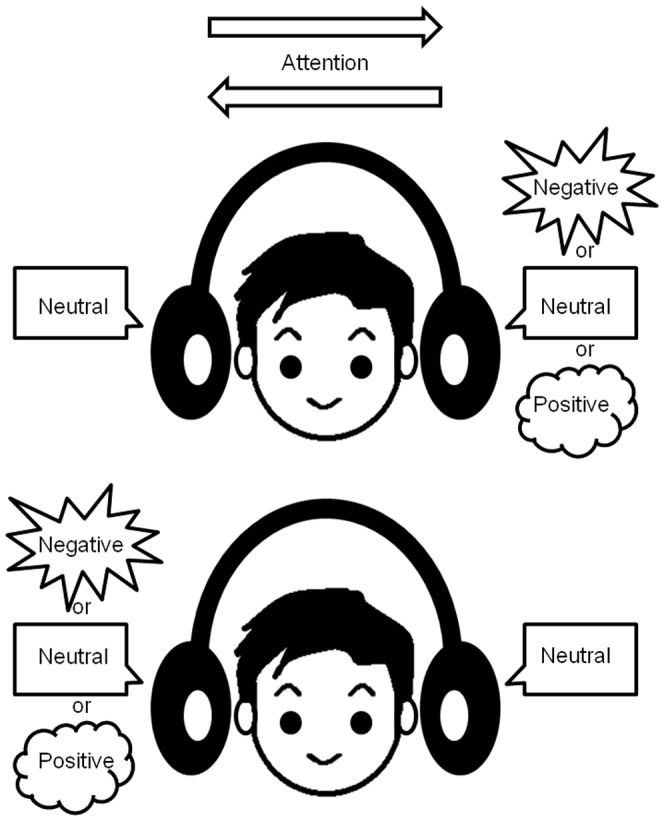
Experimental paradigm.Participants were asked to selectively attend to either the right- or left-sided voice stimulus within a pair. Then, they were required to select the word heard at the attended ear from four presented candidate words on the screen as quickly as possible. Orthogonally to the task demands, voices could have a semantically different emotional valence, either neutral on both sides, negative (or positive) on the attended side and neutral on the other side, or vice versa, neutral on the attended side and negative (or positive) on the other side.